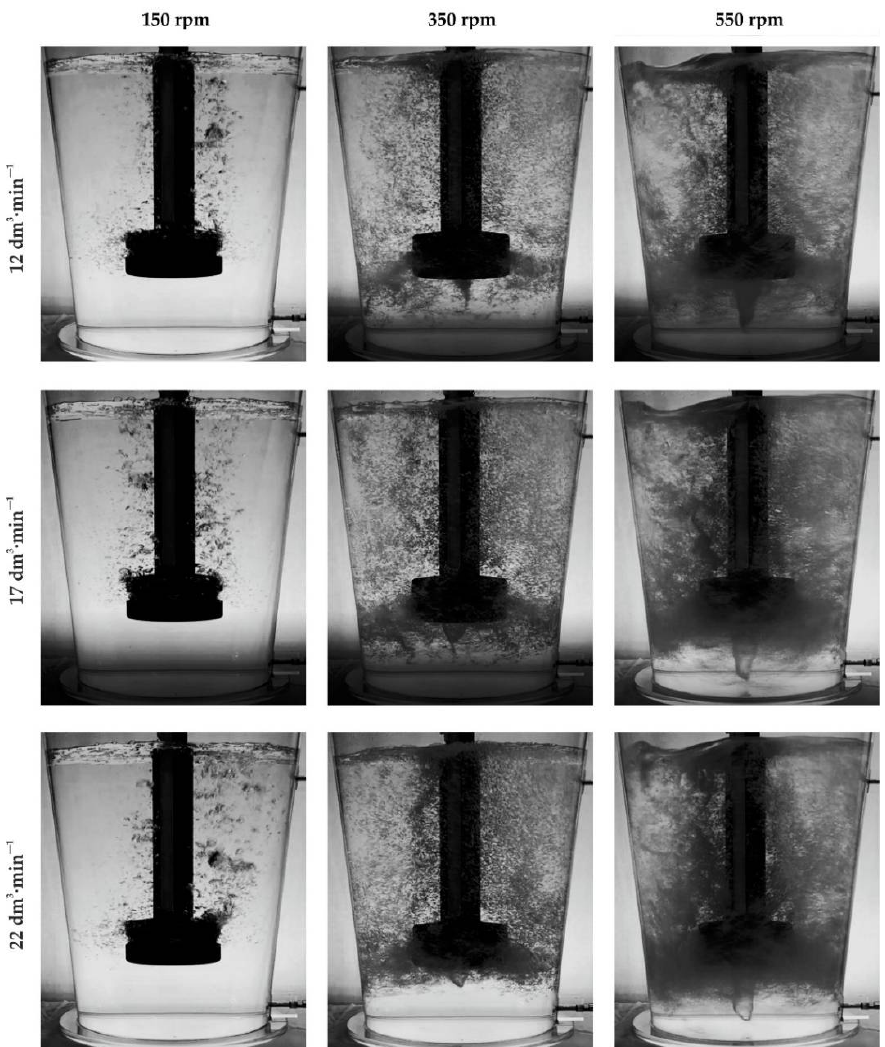
Figure 4. Demonstration of the nature of internal flow, behavior and distribution of emerging bubbles of blown argon.